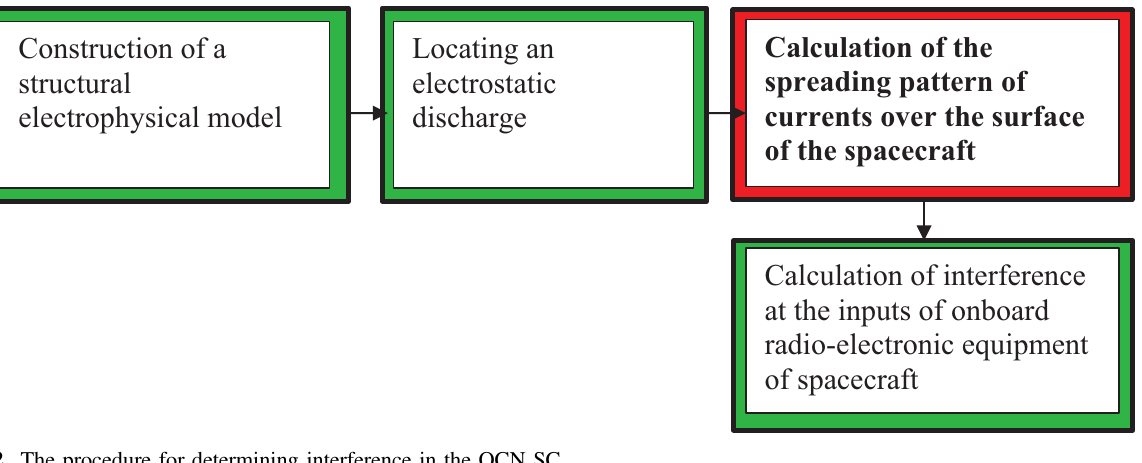
Figure 2. The procedure for determining interference in the OCN SC.